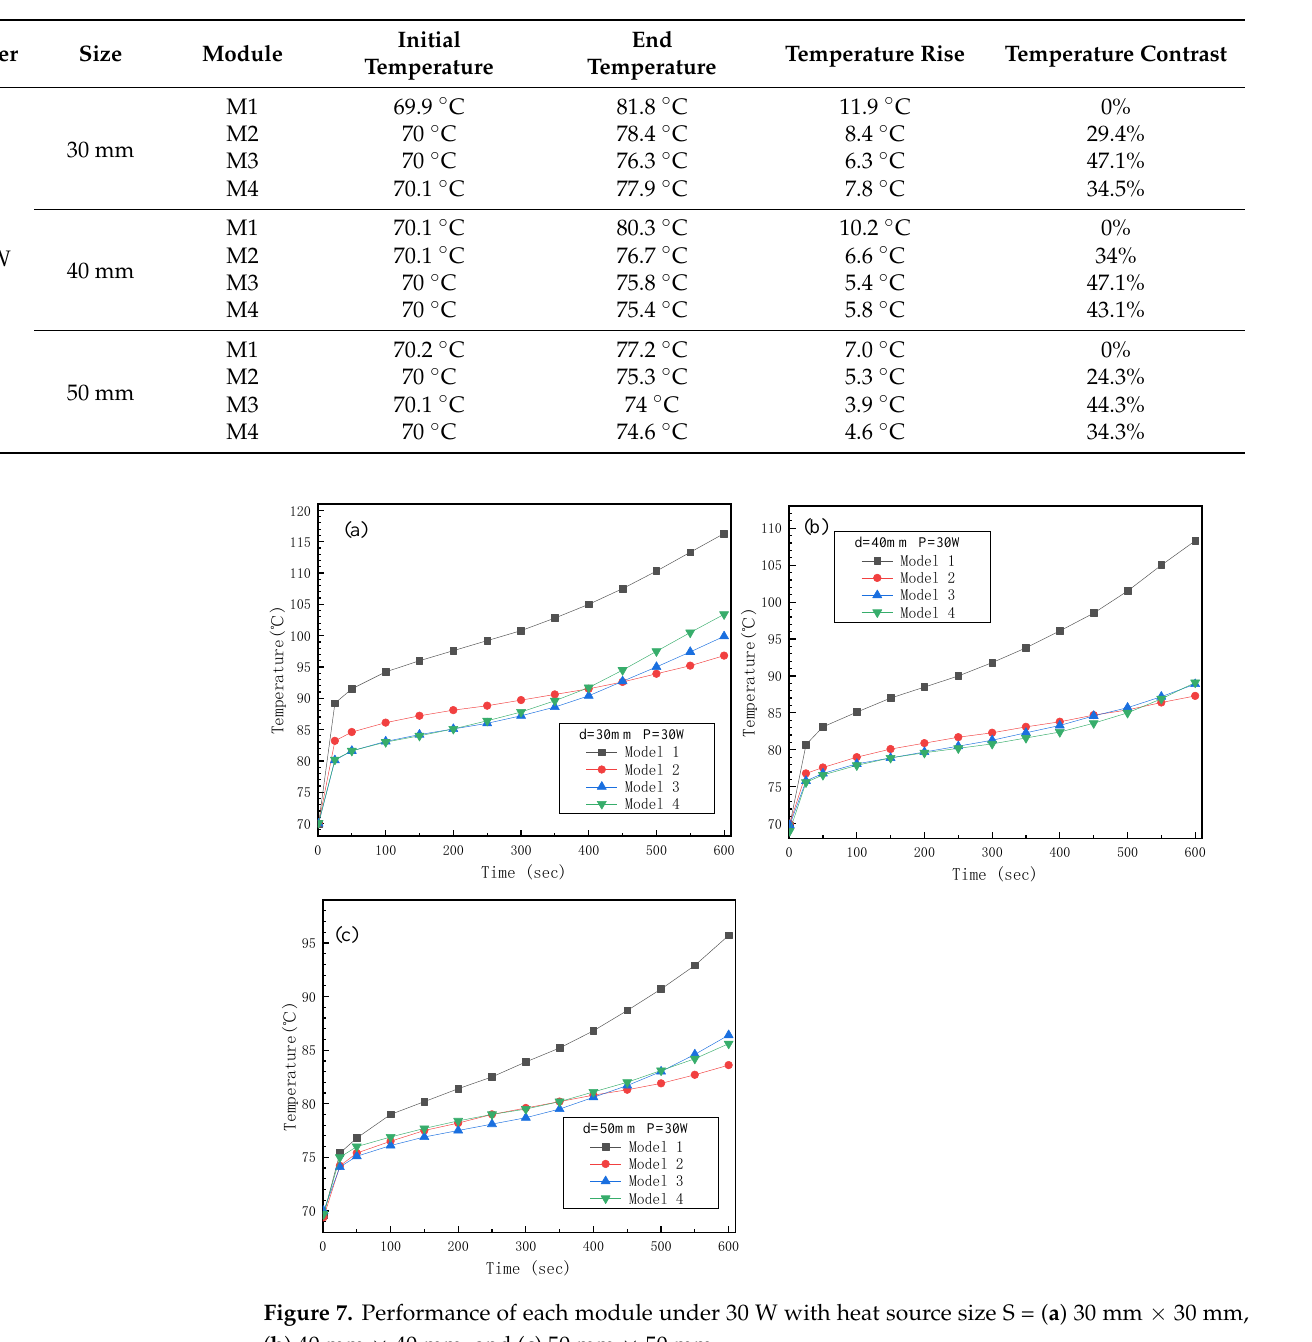
Table 4. The temperature of different size heat sources under each cooling module working at 10 W power for 10 min.